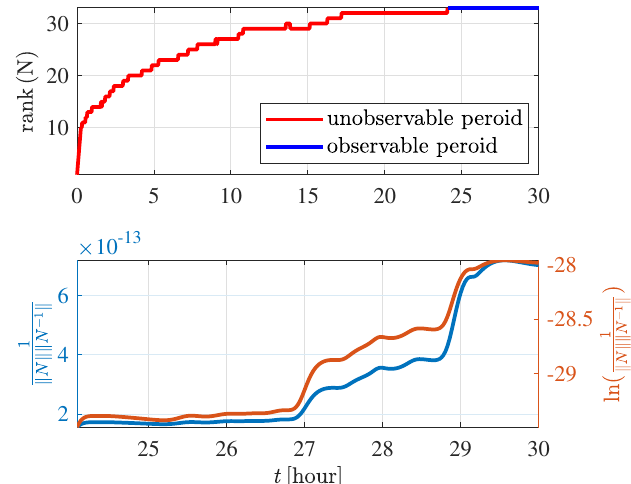
Figure 5. Observability analysis results of the eighth-order